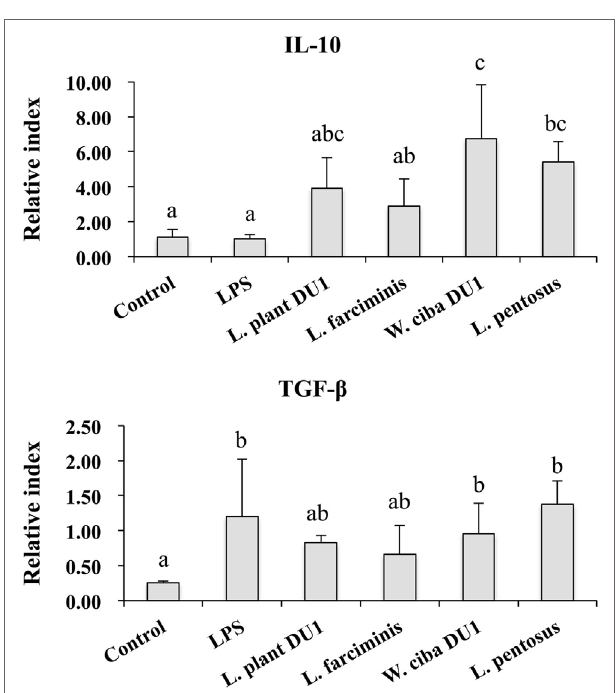
FigUre 5 | Lactic acid bacteria (LAB) strains reduced the expression of inflammatory cytokines in THP-1 cells co-cultured with HepG2 cells. In the co-culture setup, the apical side that contain HepG2 cells were stimulated with heat-killed LABs for 48 h, after which THP-1 cells that taken in the basolateral side was treated with LPS for 12 h. The expressions of IL-6 and IL-1- β were investigated by RT-PCR. Cells treated with either medium or LPS alone were used as controls. The results presented as an average values (mean ± SD) of three independent experiments. Different superscript letters indicate significant differences at the 0.05